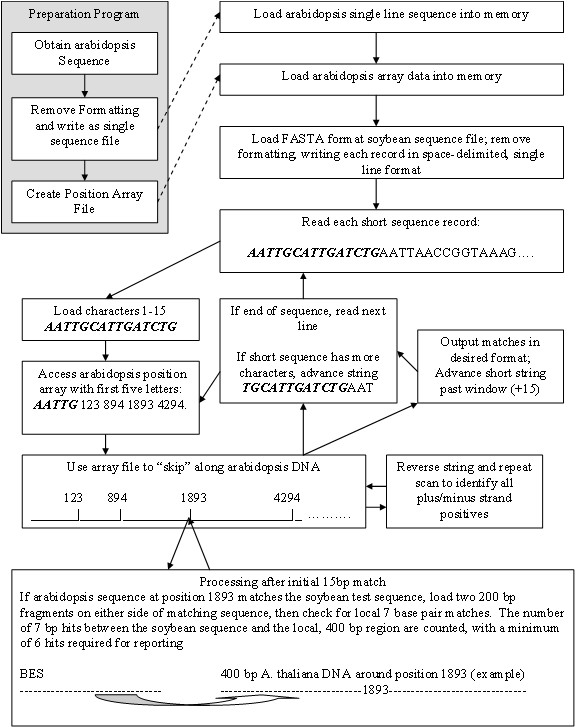
General program flow diagram for comparison of short (<1,000 bp) sequences against a model genome. In this example, soybean EST, BES, RFLP and SSR amplicon sequence is compared to the five chromosomes of A. thaliana.